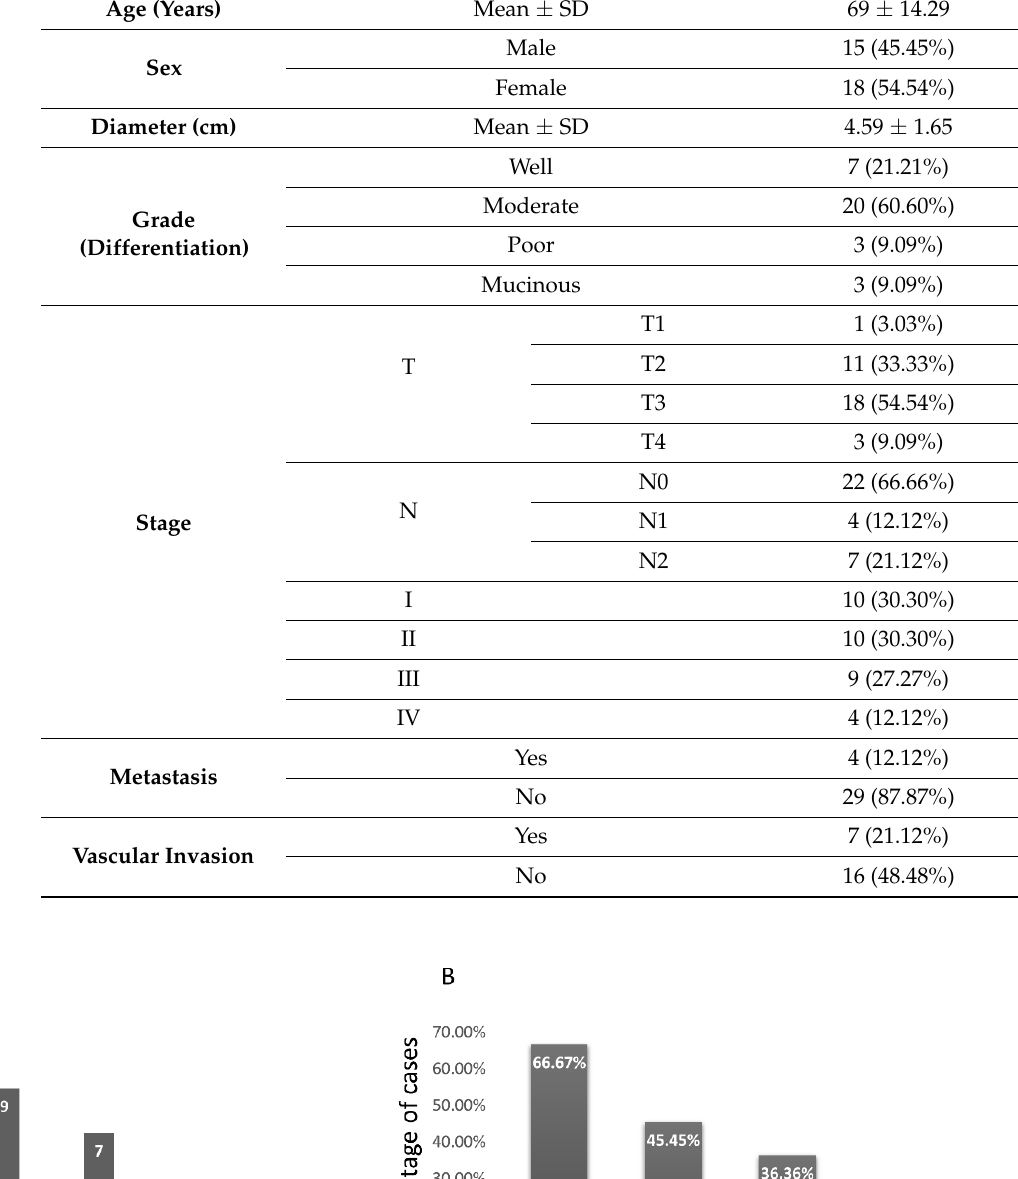
Table 1. Patient characteristics of colon carcinoma patients.